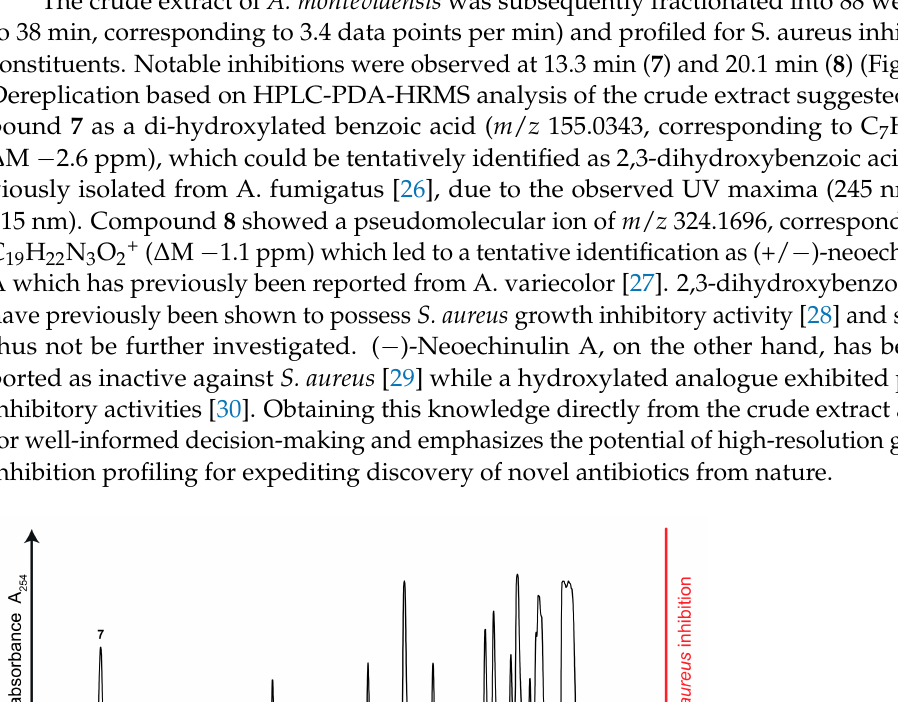
Figure 5. Comparison of HPLC chromatograms at 280 nm of ciprofloxacin ( A ), crude extract of Alternaria sp. ( C ) and the Alternaria sp. extract spiked with ciprofloxacin ( B ), separated on a C 18 column. Corresponding high-resolution S. aureus growth inhibition profiles are shown below in red highlighting the S. aureus growth inhibition of ciprofloxacin.